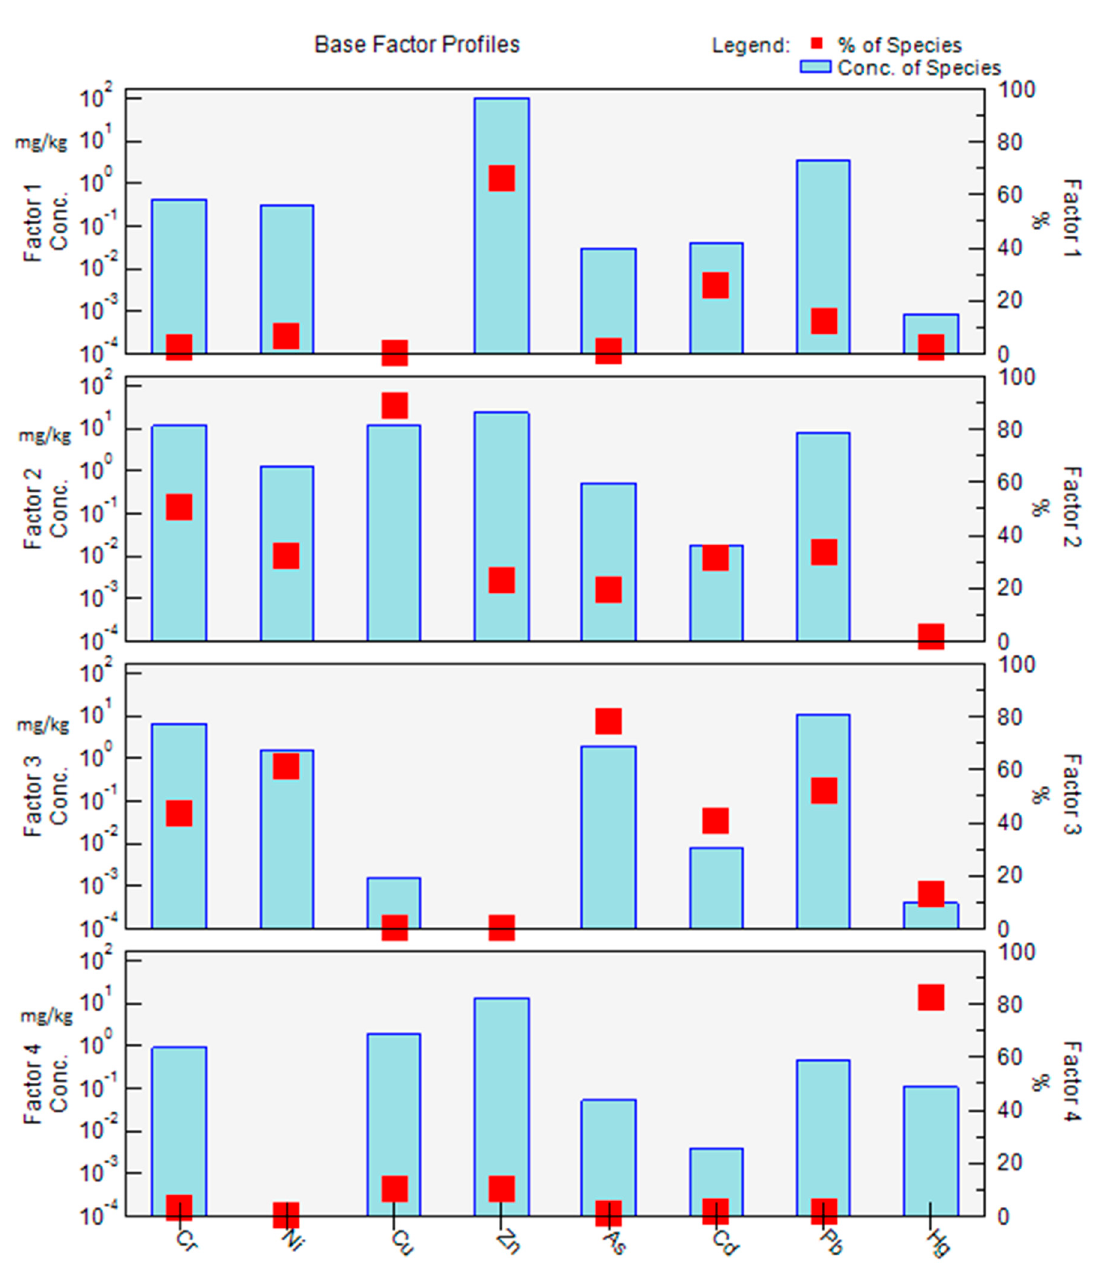
Figure 3. Base factor